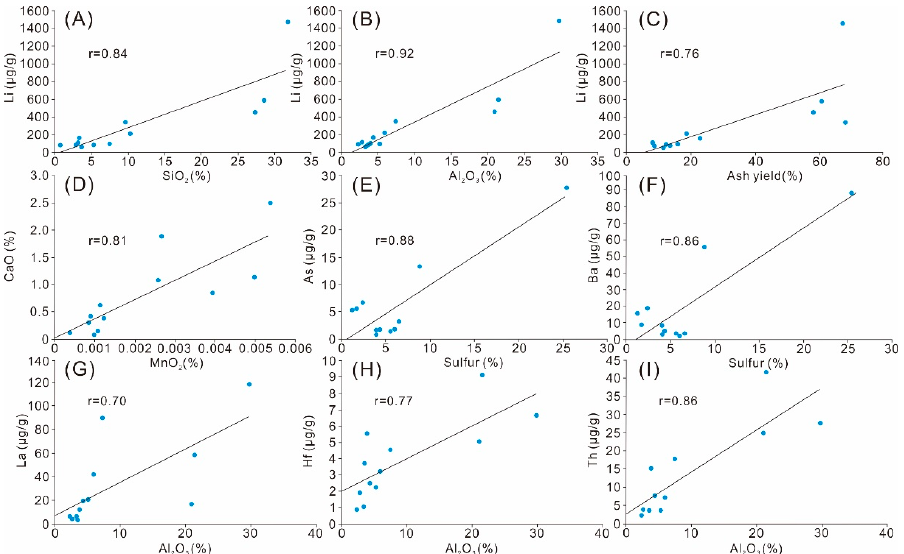
Figure 7. Correlations between selective element concentrations or with high-temperature ash(HTA) yield in the No. 11 coal (on a whole-coal basis). ( A – C ). Correlations of Li concentration with SiO 2 , Al 2 O 3 content and HTA yield; ( D ) Correlations between CaO and MnO 2 content; ( E–F ) Correlations of As and Ba concentration with sulfur content; ( G–I ) Correlations of La, Hf, and Th concentration with Al 2 O 3 content.